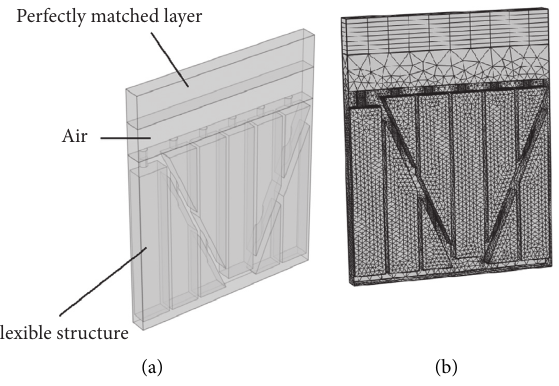
Figure 5: (a) COMSOL simulation of the flexible structure physical field. (b) Mesh of the